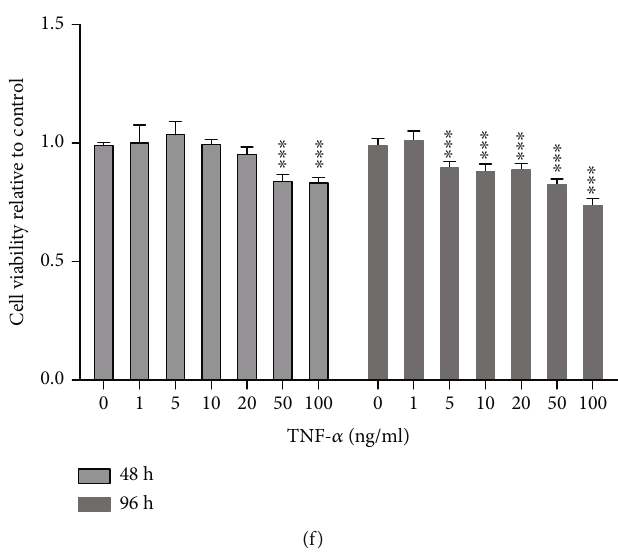
Figure 7: Expression di ff erence analysis of microRNA in MenSCs-sEV and MenSCs-sEV TNF- α . (a) Heat map of microRNA expression di ff erence between MenSCs-sEV and MenSCs-sEV TNF- α of microRNA sequence. (b) KEGG was used to analyze the signaling pathways involved in the di ff erential expression of microRNA between MenSCs-sEV and MenSCs-sEV TNF- α . (c) MicroRNA sequencing results were veri fi ed by qPCR. After 0, 1, 2, 3, and 4 days of TNF- α pretreatment, the expression value of miR-24-3p relative to u6 increased with the pretreatment days. (d, e) The di ff erence of microRNA expression between MenSCs-sEV TNF- α and MenSCs-sEV was presented by the volcano map and microRNA scatter map. (f) The viability of MenSCs treated with TNF- α of di ff erent concentrations was detected by the CCK8